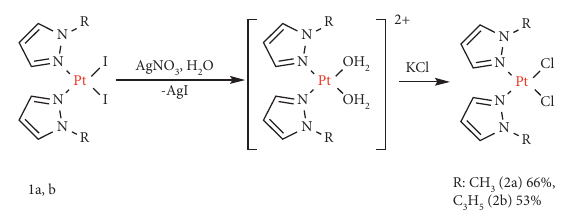
Figure 2: Synthesis of platinum (II) dichlorido